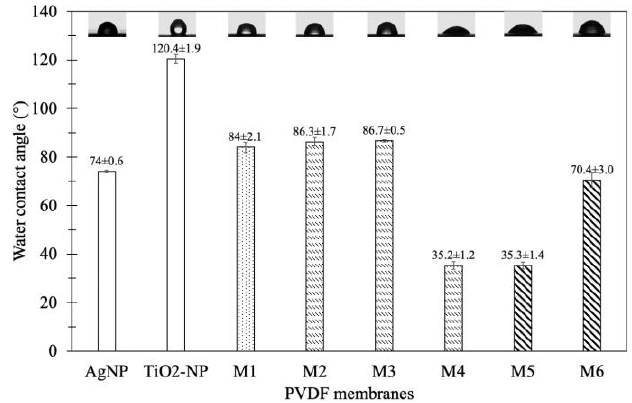
Figure 2. The water contact angle (WCA) of M1 (original), M2 (8 h), M3 (16 h), M4 (24 h) at mixed 10 ppm TiO 2 -NP / 10 ppm AgNP, and M5 (10 ppm TiO 2 -NP / 20 ppm AgNP) and M6 (20 ppm TiO 2 -NP / 10 ppm AgNP) at coating time of 24 h.